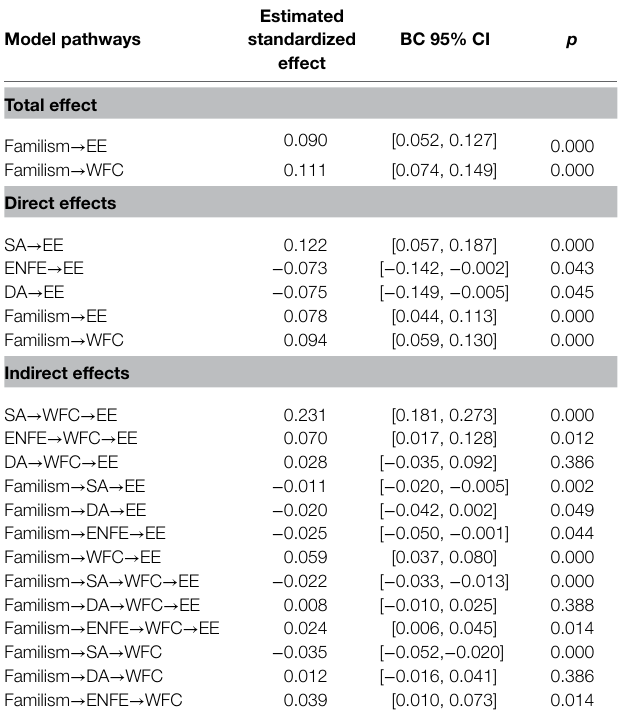
TABLE 3 | Direct and indirect effects and 95% confidence intervals in the test model.